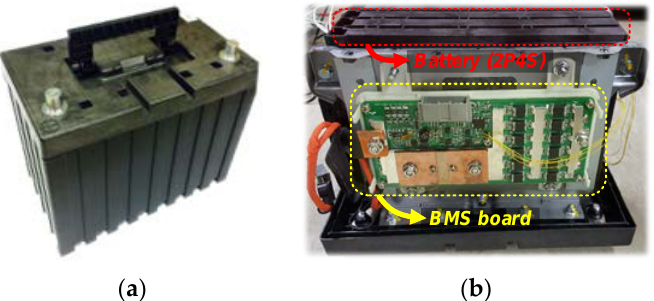
Figure 12. Simulation verification of online update process: ( a ) Update results of R s1 ; ( b ) Update results of L s1.